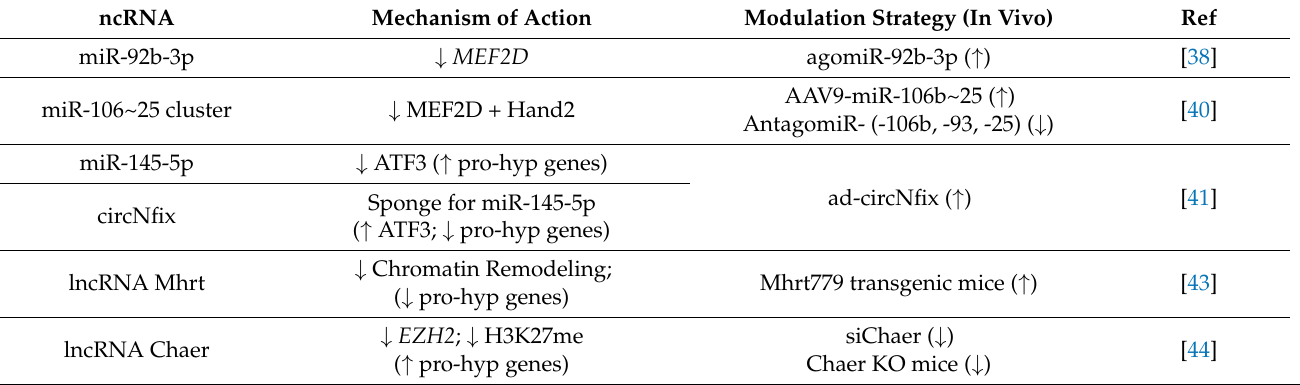
Table 1. ncRNAs modulating gene expression programs involved in concentric cardiac